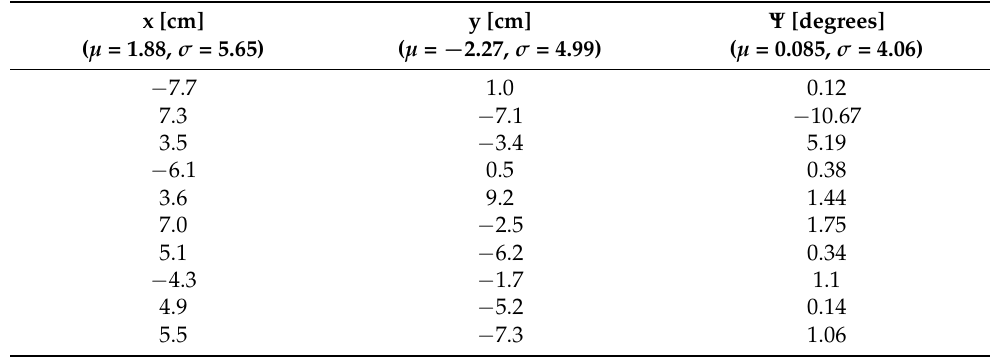
Table 11. Results of the targeted landing experiment. The mean value µ and the standard deviation σ are indicated for each respective parameter.